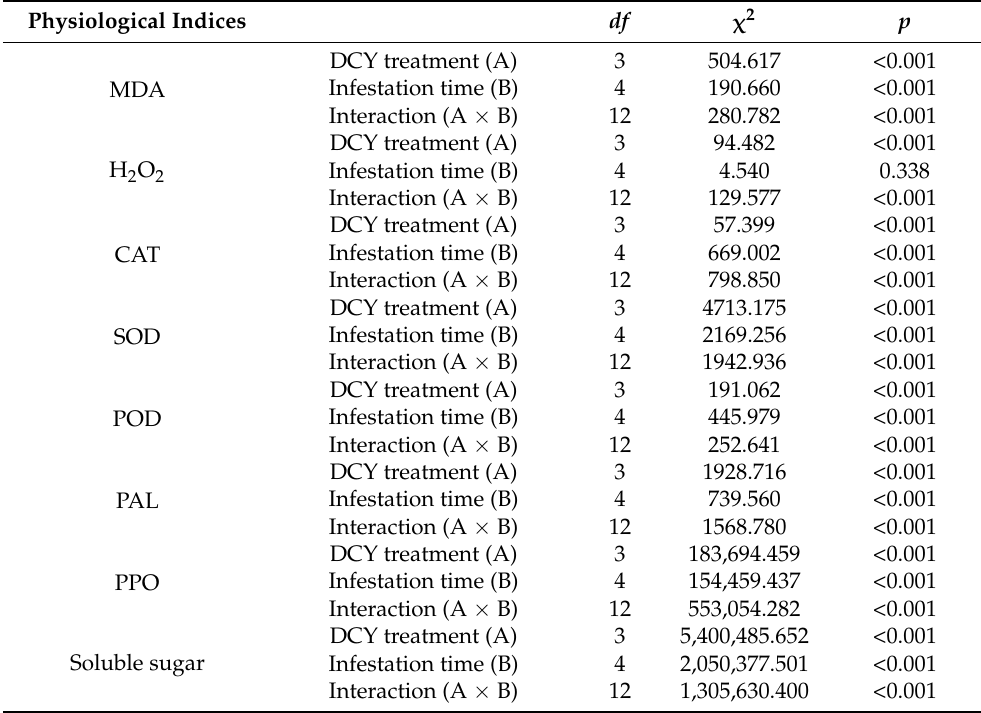
Table 3. Generalized linear model for significance effect ( p value) of DCY treated plants, SBPH infestation duration on plant protective enzymes activities and concentrations of MDA, H 2 O 2 and soluble sugar.